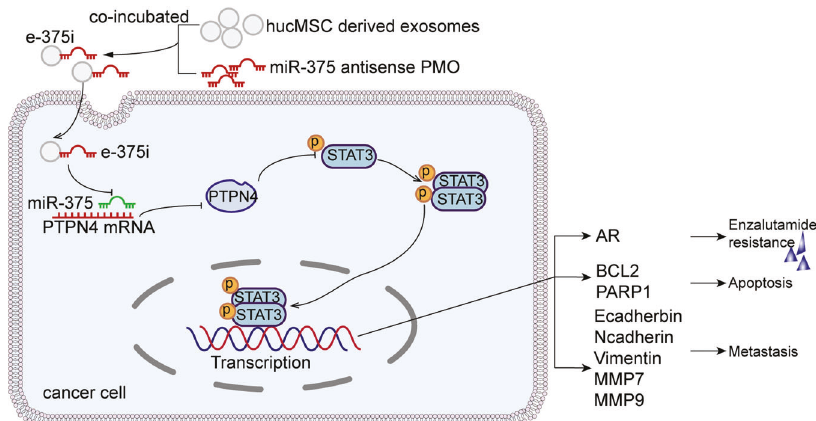
Fig. 10 Schematic of e-375i elicited anti-PCa effects. Shown is the graphical illustration of the identi fi ed pathway of miR-375 in regulating PCa progression and enzalutamide